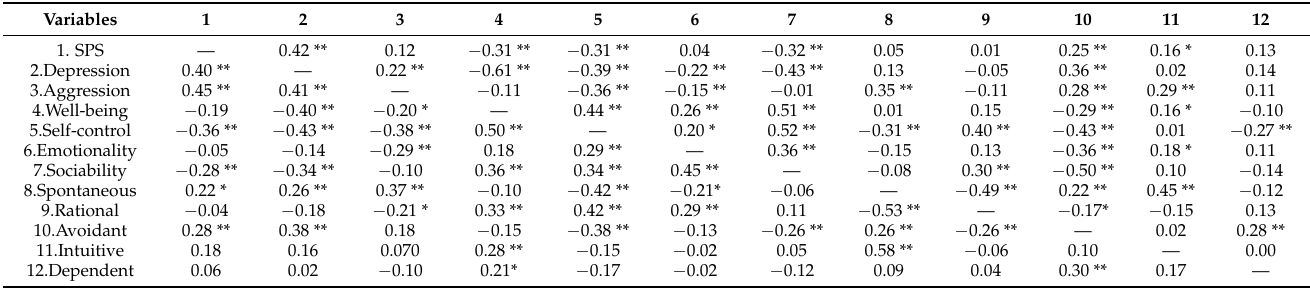
Table 3. Correlations among study